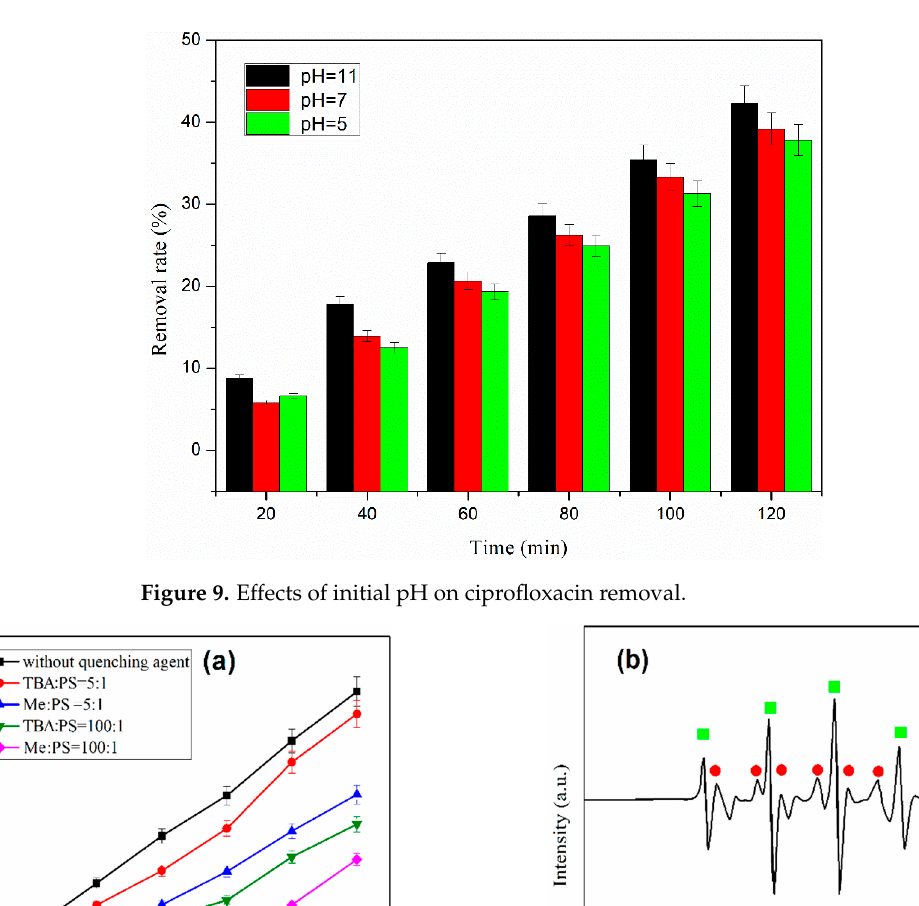
11 of 16 Figure 8. Effects of initial concentration ratio on removal effect of ciprofloxacin. 3.6. Effect of Initial pH on CIP Removal Efficiency To investigate the effect of initial pH value of the solution on the removal of ciprof- loxacin by US/E/PS system, the experimental conditions were set as follows: the initial molar concentration of ciprofloxacin was 0.03 mmol/L, the initial molar concentration of PS was 1.5 mmol/L, the electrode potential was 4 V, the ultrasonic power was 100 W, and the reaction temperature was 35 °C. The pH of the system was adjusted to make the solu- tion acidic, neutral, and alkaline (pH values were 5.0, 7.0, and 11.0, respectively). The trend of ciprofloxacin removal rate after reaction for 120 min is shown in Figure 9. When